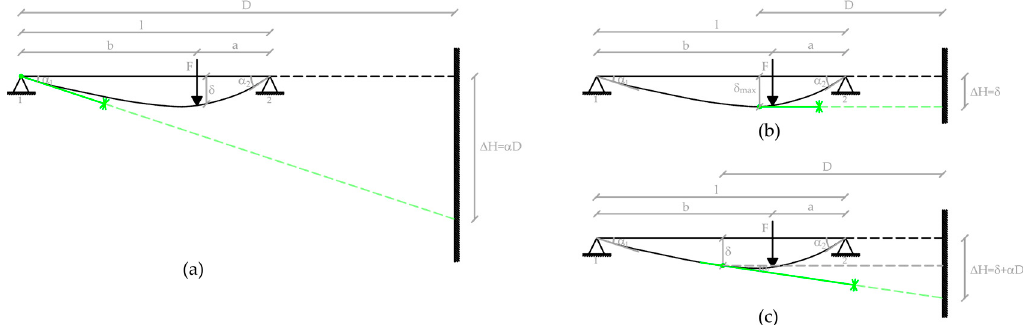
Figure 1. The displacement of the laser footprint in three cases: ( a ) laser fixed to a point subject only to inclination; ( b ) laser fixed to a point subject only to lowering; ( c ) laser fixed to a point with both inclination and lowering.